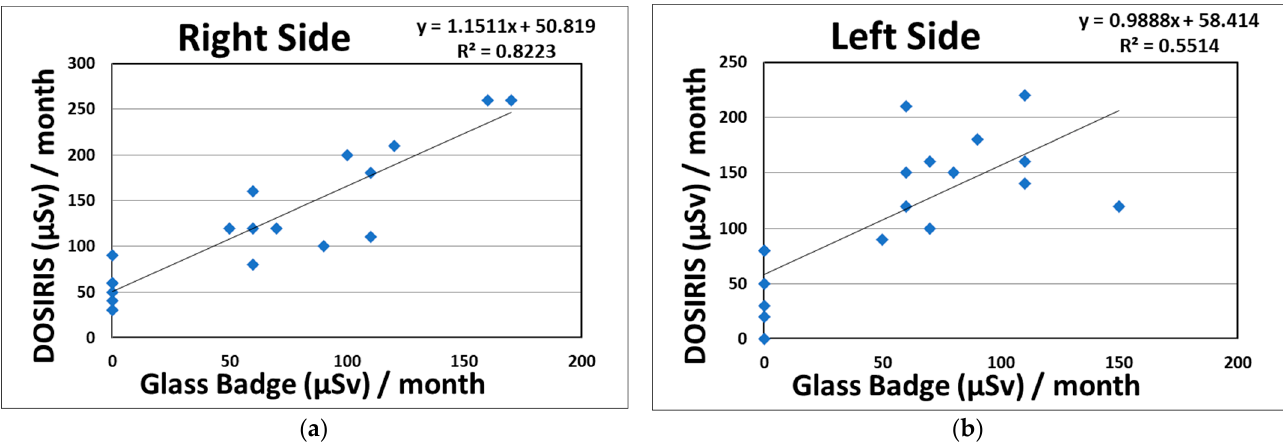
Figure 2. Relationship between the eye dosimeter (DOSIRIS, Hp (3)) and neck dosimeter (Glass Badge, Hp (3)), taken monthly during CTF-guided biopsies (95 procedures). ( a ) Right side dosimeter; ( b ) left side